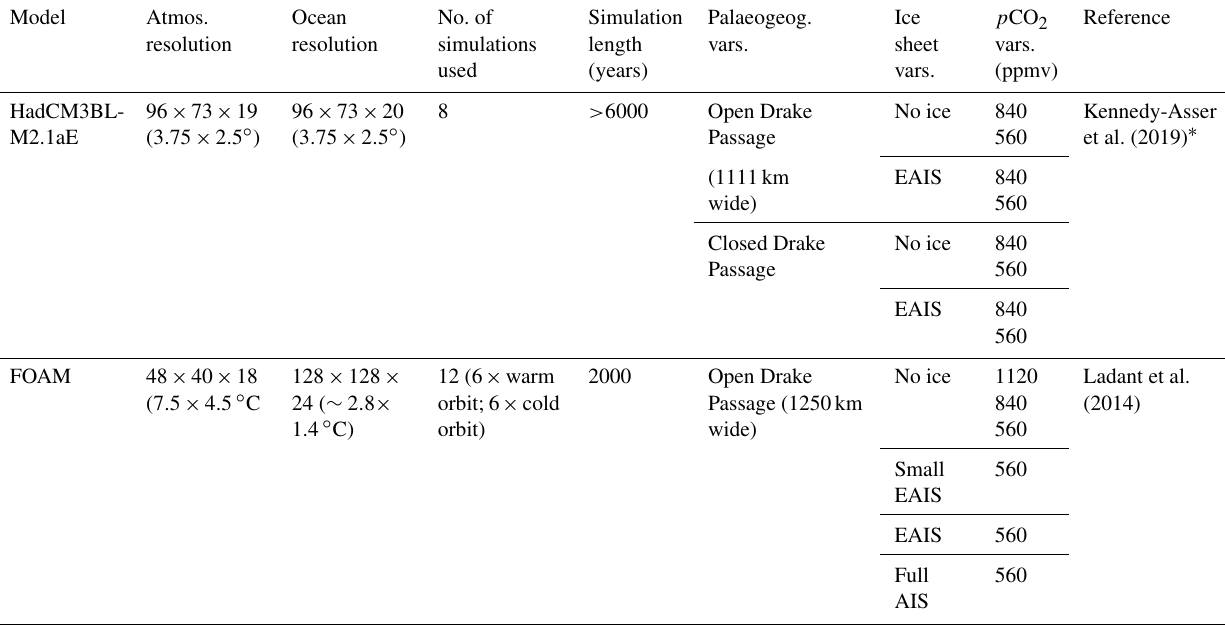
Table 1. Brief overview of climate models and the boundary conditions varied for each.